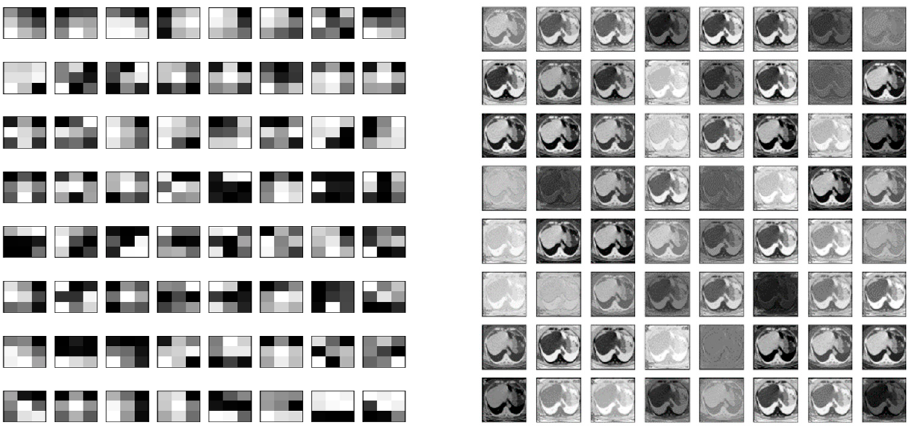
Figure 7. The figures above show 64, 3 × 3 filters in the first convolution layer and 64, 256 × 256 filters in the fourth layer during training.